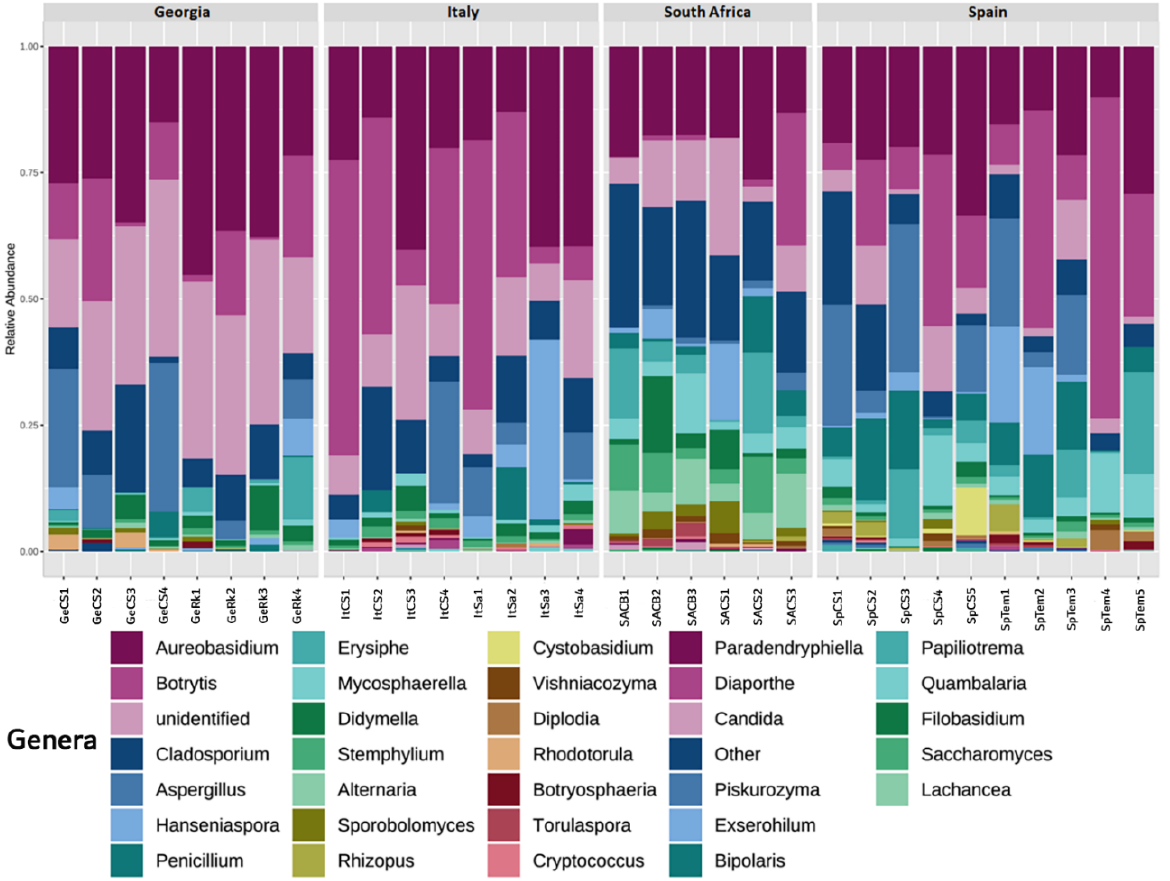
Figure 2. Relative abundance and taxonomic assignment of genera in the 32 samples from the four countries. Sample code: Ge, Georgia; It, Italy; SA, South Africa; Sp, Spain; CS, Cabernet Sauvignon; Rk, Rkatsiteli (Ge); Sa, Sangiovese (It); Tem, Tempranillo (Sp); CB, Chenin Blanc (SA).